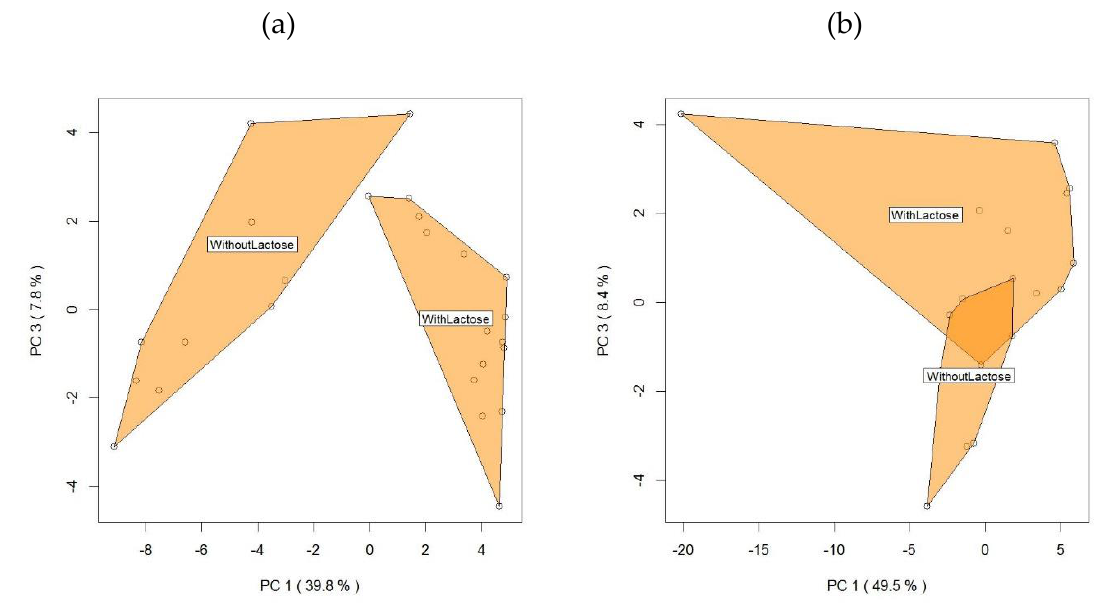
Figure 4. Analysis of mascarpone VOCs profile assessed by PTR-ToF-MS for the Manufacturers C ( a ) and M ( b ) plotted by the first and the third principal components. The labels and the selected areas indicate the separation between samples with or without lactose.